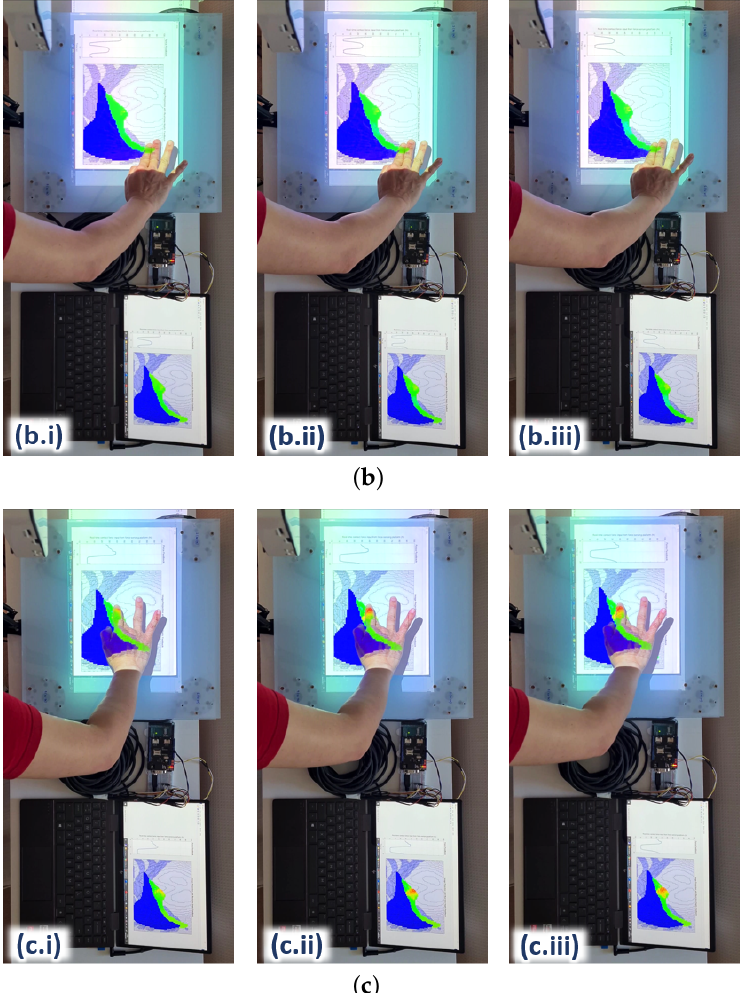
Figure 11. Palpation onto the force-sensing platform with real-time force feedback and stress distribu- tion projection onto the platform at locations A, B, and C. ( a ) Palpation location A with approximate incremental forces ( a.i ) 6 N, ( a.ii ) 27 N, and ( a.iii ) 37 N. ( b )Palpation location B with approximate incremental forces ( b.i ) 6 N, ( b.ii ) 27 N, and ( b.iii ) 37 N. ( c ) Palpation location C with approximate incremental forces ( c.i ) 6N, ( c.ii ) 27N, and ( c.iii )